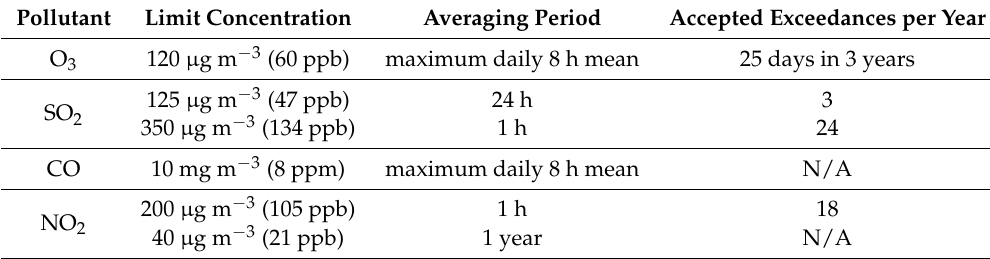
Table 2. European standards for air